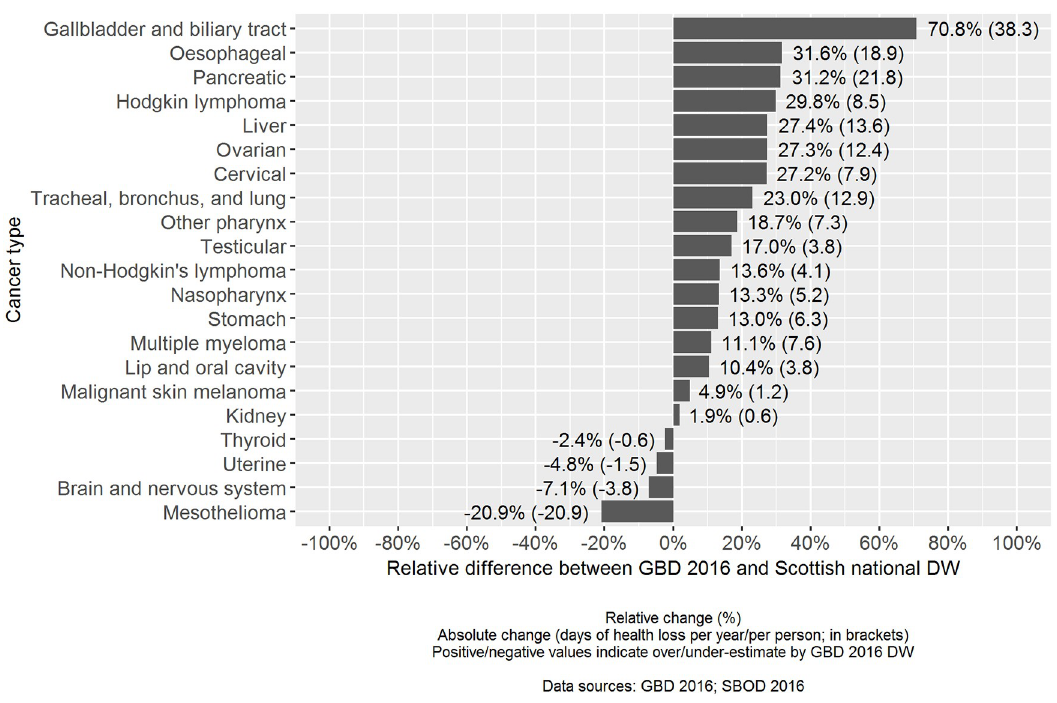
Fig 1. Relative and absolute comparison of cancer disability weights: GBD 2016 worldwide versus Scottish national.